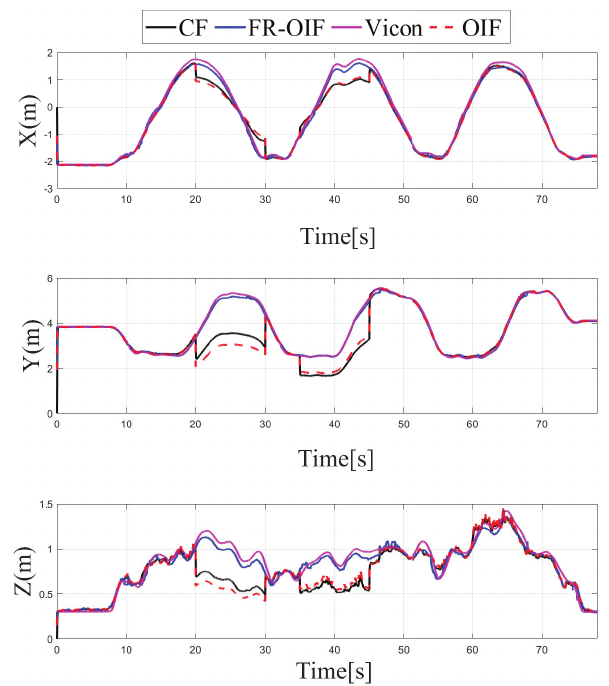
Figure 10. Case-3: Estimated positions along ‘X-Y-Z’ components obtained from intermediate nodes ( A , . . . , G ) and FR-OIF, compared with CF, OIF and the ground truth. The evaluation is carried out in presence of temporal fault appearing from UWB (20–30) s and LIO (35–45) s. Except the fused position obtained from FR-OIF all the estimated positions deviated in presence of faulty measurements.